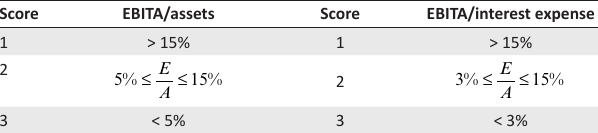
TABLE 2: Assumed internal rating model for mining (illustrative example).